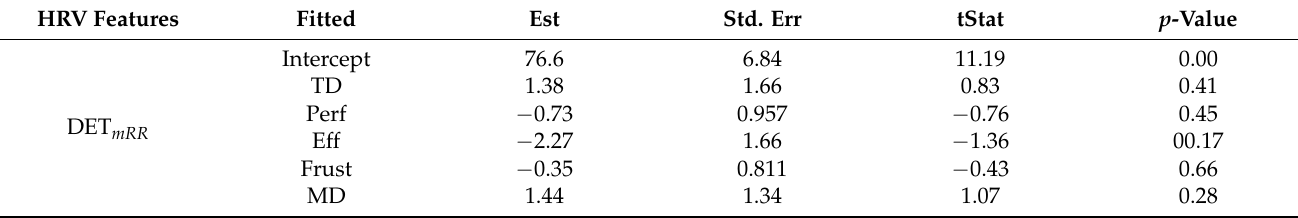
Table A1. Multiple linear regression model of MdRQA and NASA-TLX scores. Column head- ers, from left: fitted NASA-TLX scores; model estimate; standard error of the model; t statistics; p significant